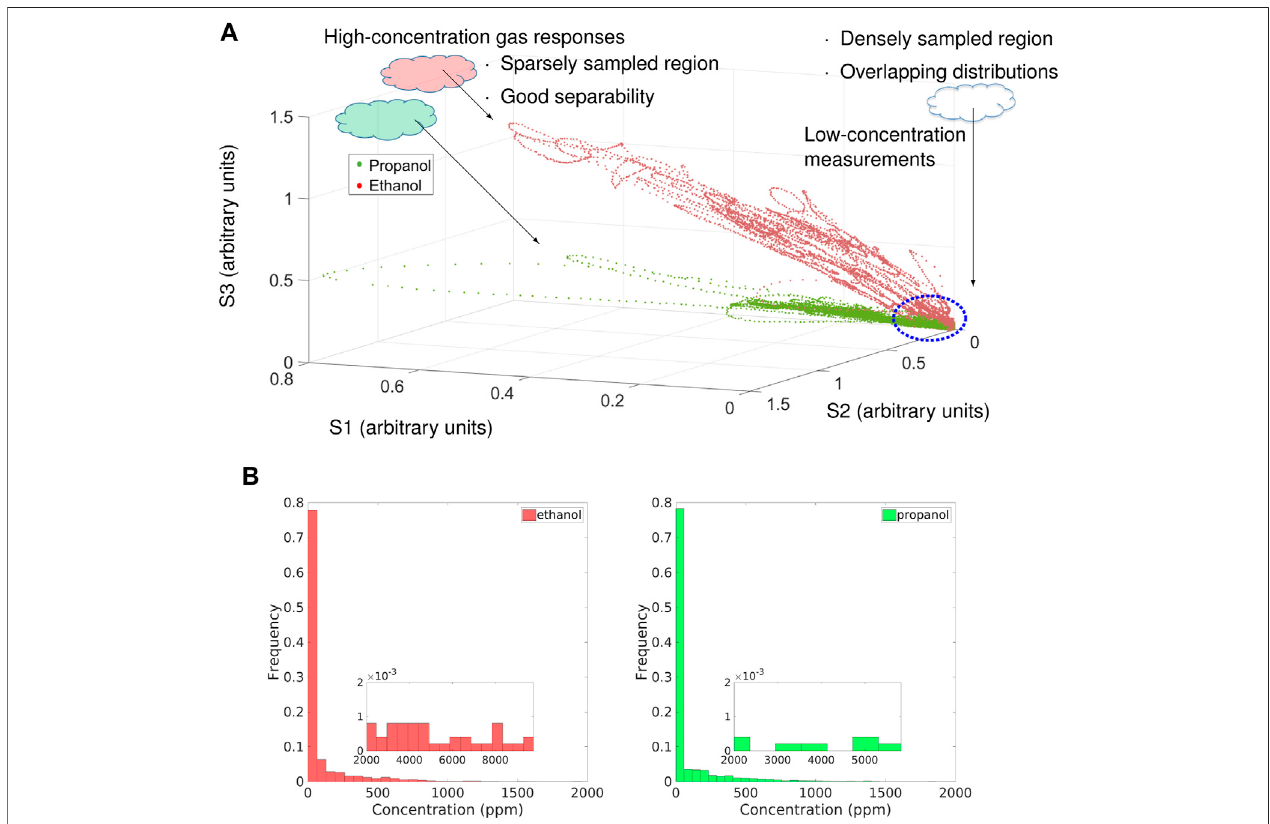
FIGURE 1 | Feature space plot and the gas concentration histograms of measurements of propanol (green) and ethanol (red) collected in an uncontrolled environment with three E2V manufactured metal oxide (MOX) gas sensors (MICS-2710, MICS-5121, MICS-5521). (A) Feature space plot. Each data point is an instantaneoussensorresponse. (B) Concentrationlevelsshowninthehistogramswereobtainedbyaphotoionizationdetector(PID).Thenested fi guresarethezoomed- in histograms at high concentrations. Both data of propanol and ethanol are clearly unbalanced with respect to the gas